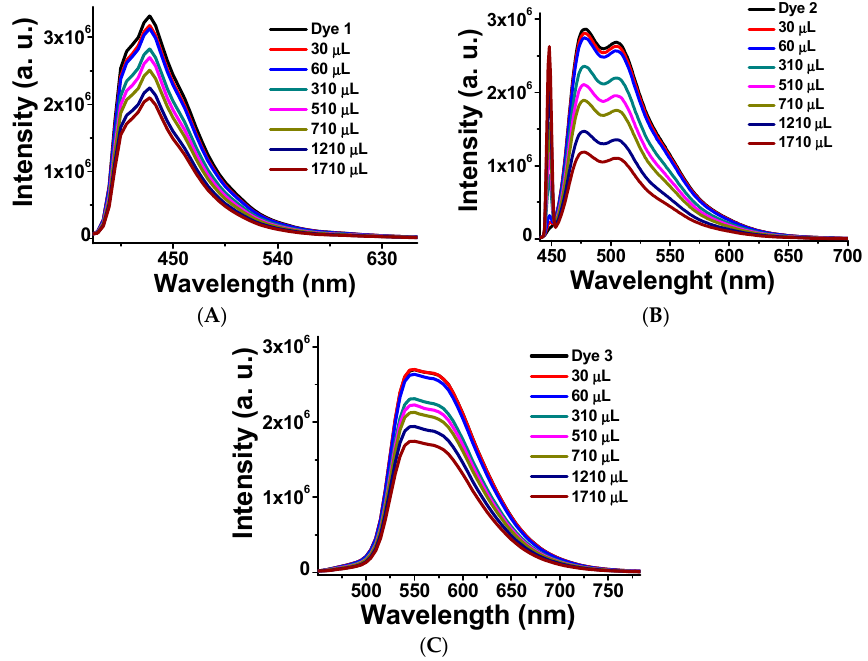
Figure 6. Fluorescence spectra of dyes 1 ( A ) ( λ ex = 363 nm); 2 ( B ) ( λ ex = 409 nm), and 3 ( C ) ( λ ex = 442 nm) upon addition of increasing amounts of CNHs (0.01 mg/mL). The solvent of these measurements was DMF and the concentration of the organic compound constant during the